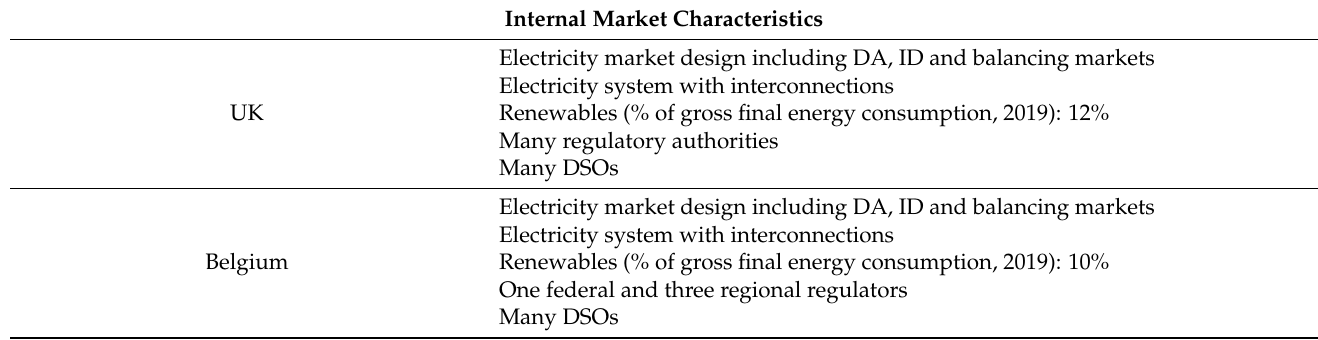
Table 4. Summary of the characteristics of the reviewed